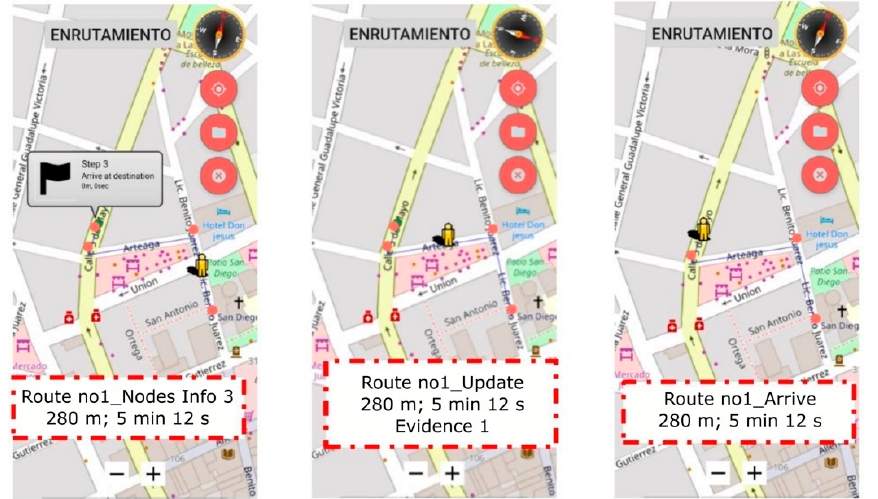
Figure 11. Subject A in E-1.